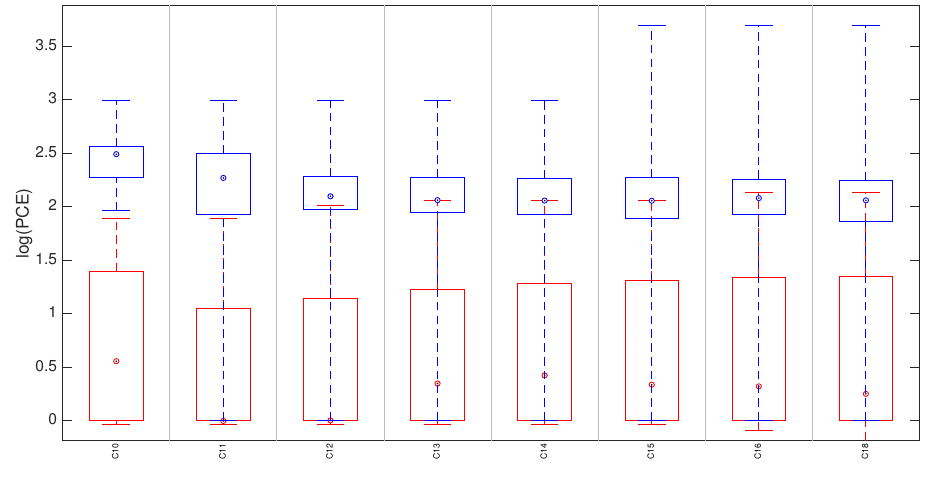
Figure 9. (Best viewed in color) Details of the performance achieved with best aggregation threshold (38) on stabilized YouTube videos using Facebook (HQ) images as references. Matching and mismatching statistics are reported in blue and red, respectively, for each of the